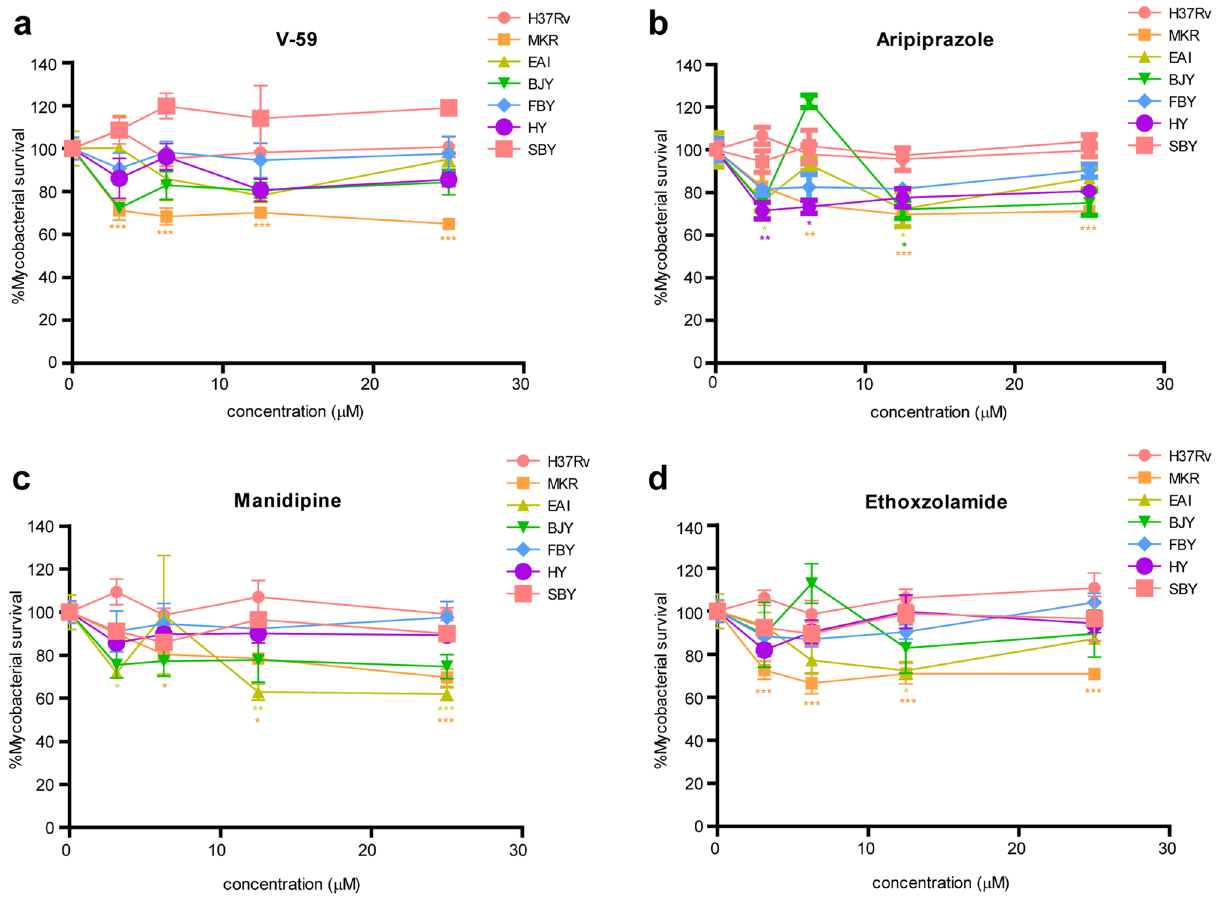
Figure 7. Intracellular survival odds of the MKR, H37Rv, and different clinical isolates upon the treatments of V-59, aripiprazole, manidipine and ethoxzolamide. ( a–d ) THP-1 cells were infected with Alexa-568- labelled MKR, H37Rv, or different clinical isolates for 30 min, and were treated with media containing various concentrations of ( a ) V-59, ( b ) aripiprazole, ( c ) manidipine and ( d ) ethoxzolamide for 3 days. Cells were then fixed and processed for high-content image analysis to quantify the number of mycobacteria per host cell. Percent mycobacterial survival at each concentration was calculated relative to that of the non-treated control group set to 100%. Two-way ANOVA with Bonferroni post-tests were used to determine if the intracellular survival levels were significantly different from that of the control group (*: p < 0.05; **: p < 0.01; and ***: p <